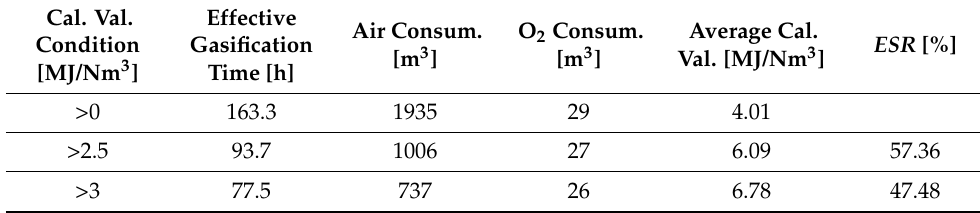
Table 4. The efficiency of the UCG process for the first experiment. Cal. Val.